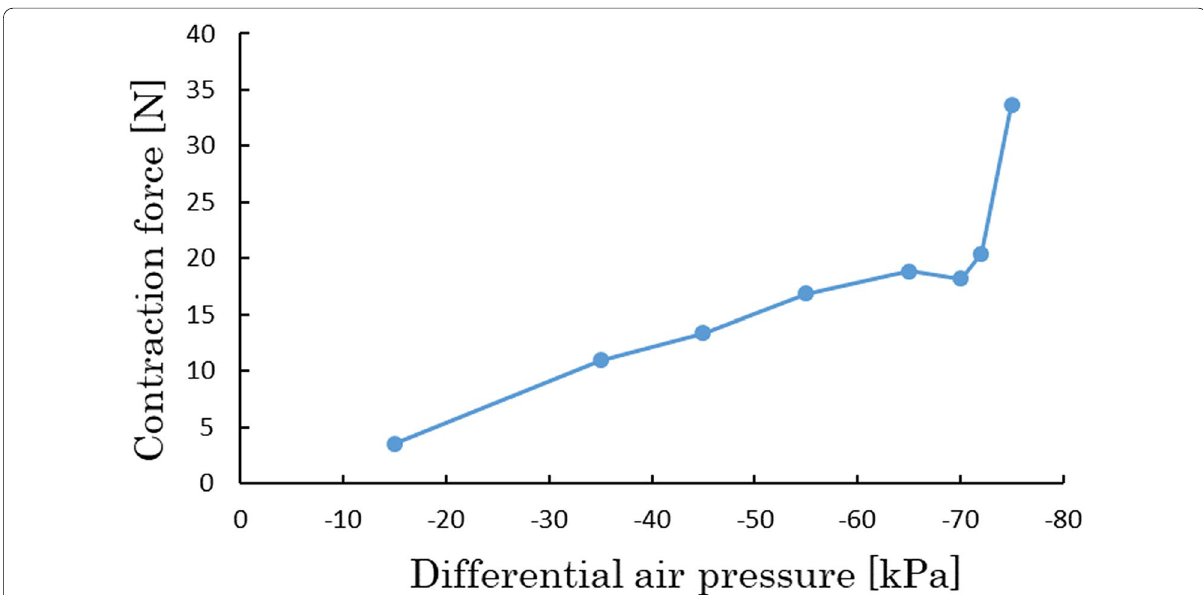
Fig. 6 Relationship between the contraction force and difference between the inside air pressure when the actuator is fixed to the instrument and that at measurement ( 75 kPa). The contraction force was almost proportional to the differential air pressure. The steep increase over − could be attributed to the change in the cross-sectional area by dents on the surface of the actuator